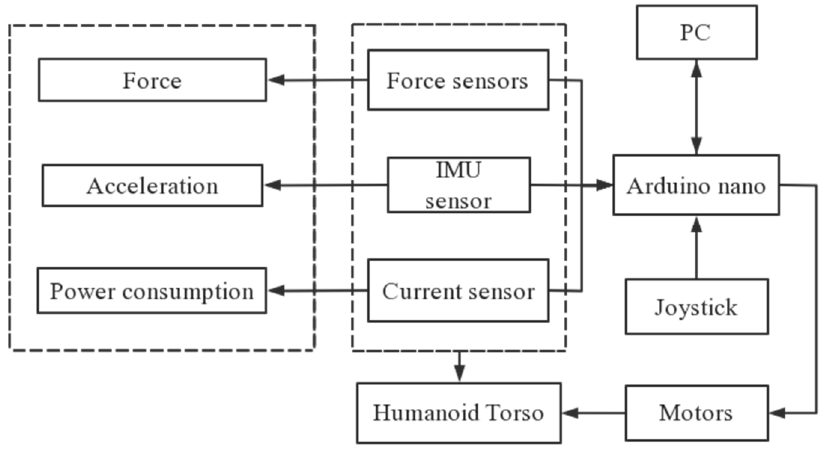
Figure 5. Testing layout of LARMbot torso V1.